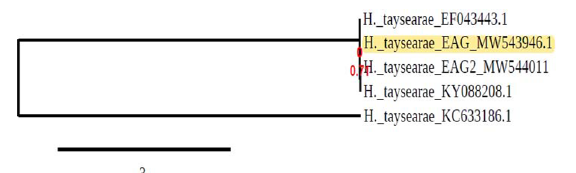
Table 1 Analysis of variance (Two-way ANOVA) for the mortality percentage of Spodoptera littoralis larvae by the new isolate of Heterorhabditis taysearae after 48 and 72 h post-treatment